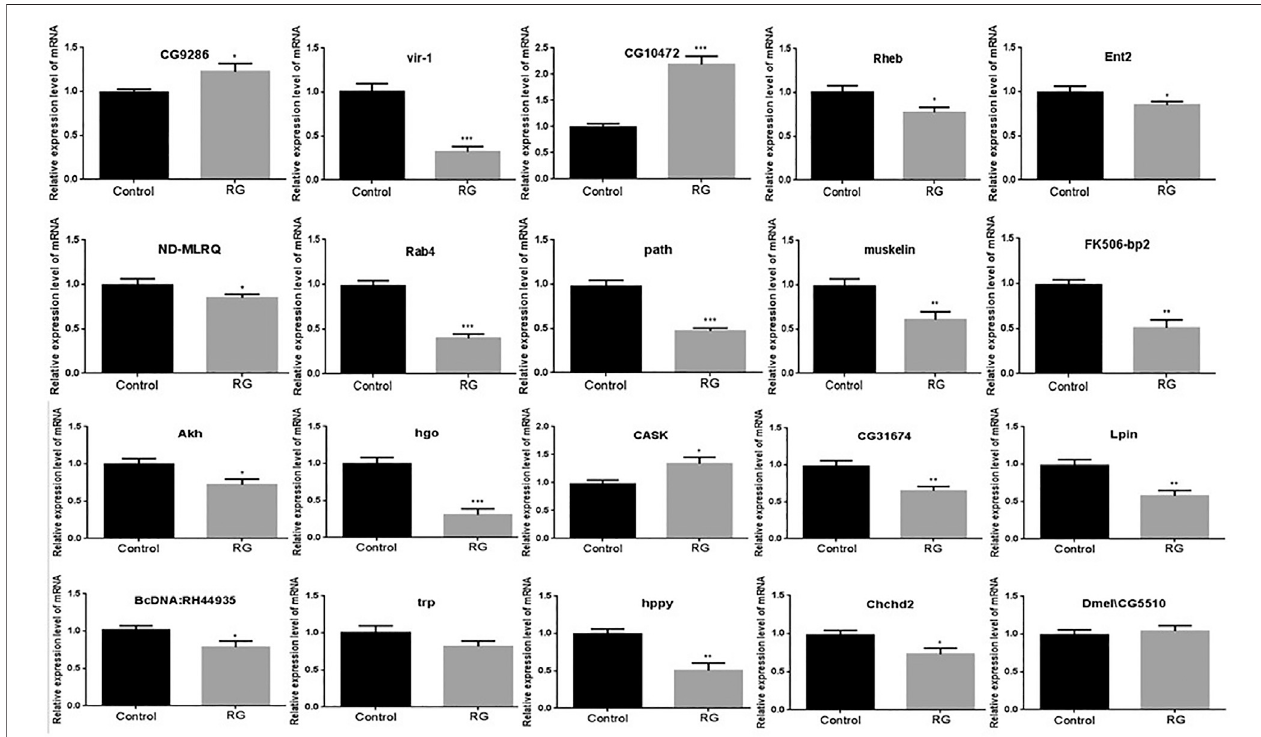
FIGURE 5 | Validation of the signi fi cantly changed proteins by qRT-PCR. p value < 0.05 was considered statistically signi fi cant.; Abbreviation: RG, red ginseng.